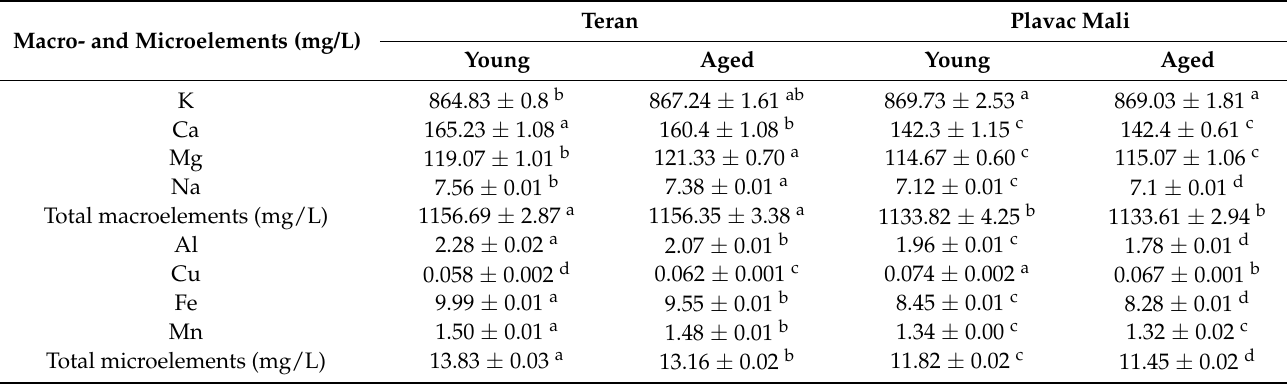
Table 6. Concentration (mg/L) of macro- and microelements in young and aged Teran and Plavac mali